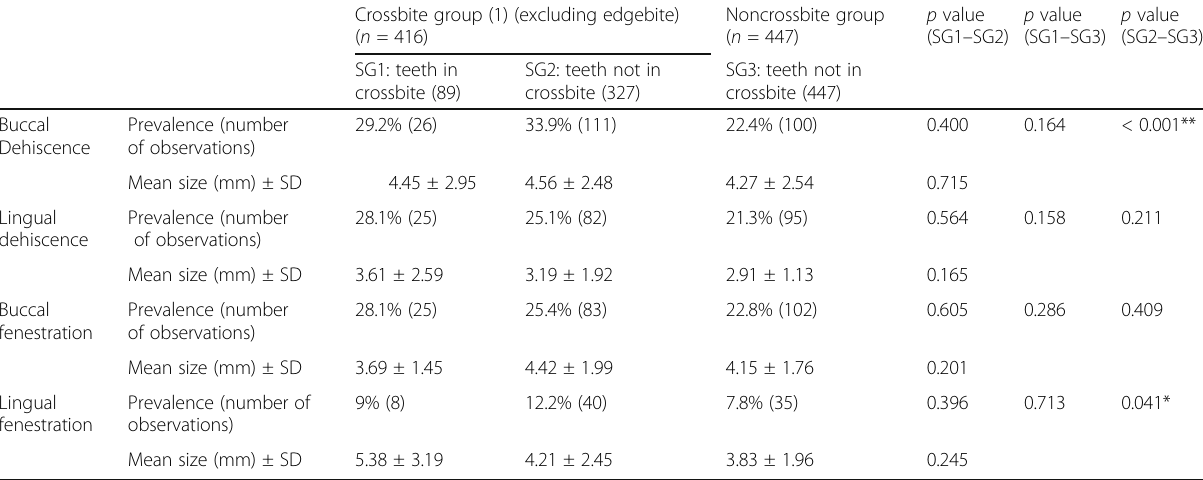
Table 12 Dehiscence and fenestration prevalence and mean size by buccal and lingual surfaces by subgroup. Teeth in edgebite were excluded